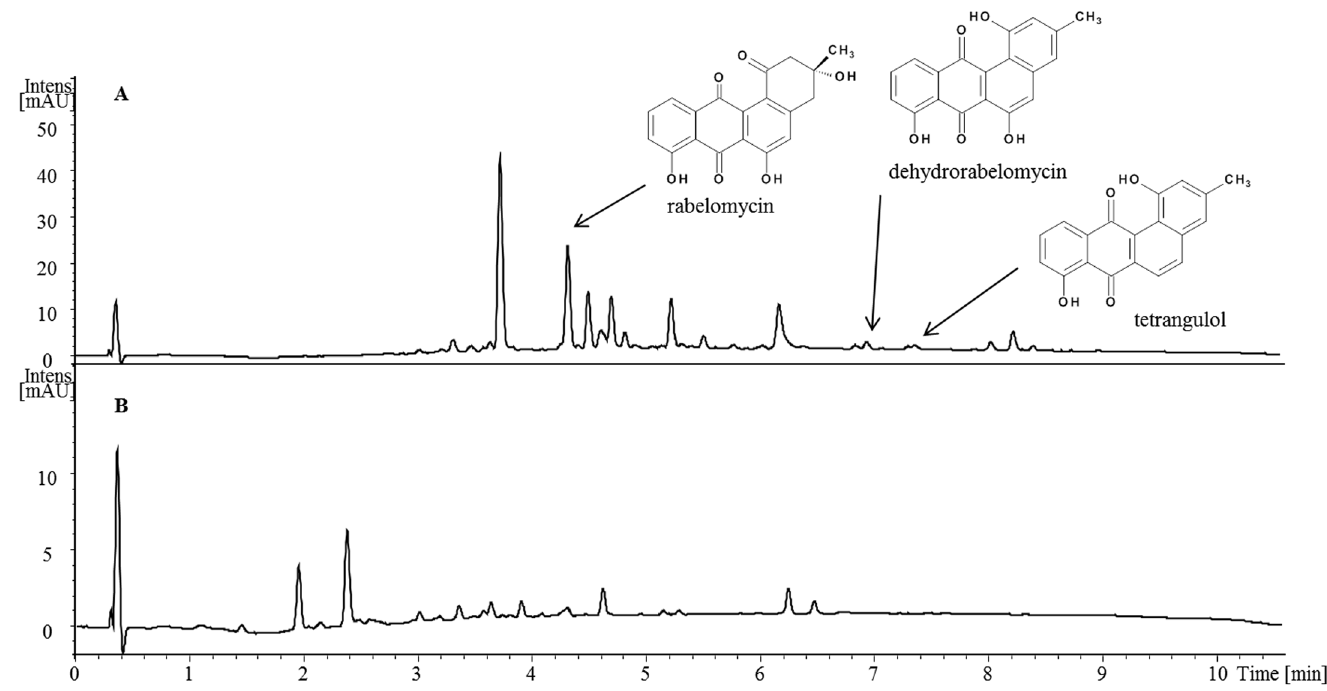
Fig 6. Chromatogramof the HPLC-ESI/MS analysis of crude extract from S . albus pGRE (A) and S . albus J1074 (B). Arrows indicate ions corresponding to rabelomycin, dehydrorabelomycin and tetrangulol. Wavelength 420